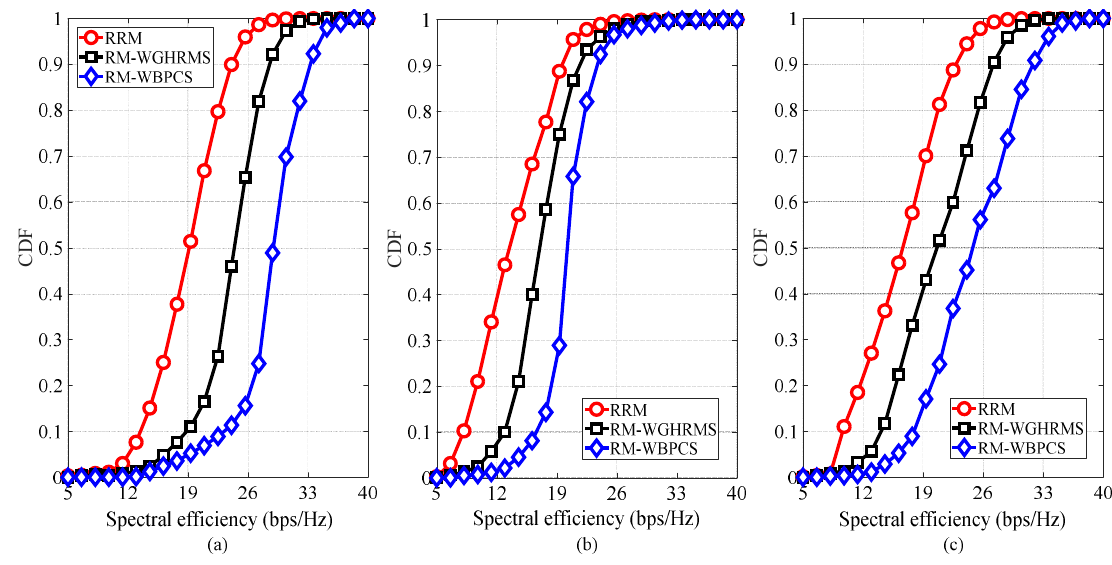
Figure 6. CDF of the spectral efficiency for ( a ) DPs, ( b ) CUs, and ( c ) the overall system.